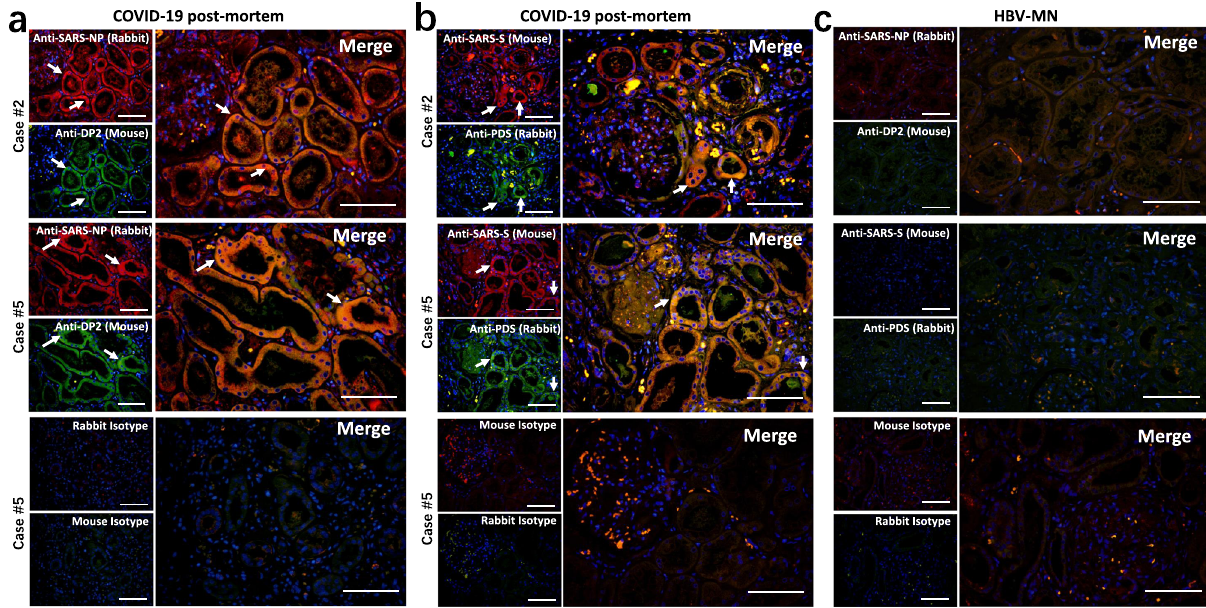
Fig. 4 SARS-CoV-2 protein antigens co-express with hypoxic damage-associated molecules in kidney. Immuno fl uorescent double staining was used to detect the expression of a SARS-CoV-2 NP (nucleocapsid protein) and DP2 in kidney tissues from COVID-19 post-mortem (case #2 and #5); b SARS- CoV-2 S (spike) and prostaglandin D synthase (PDS) in kidney tissues from COVID-19 post-mortem (case #2 and #5); c SARS-CoV-2 NP and DP2 or S and PDS in kidney tissues from hepatitis B virus-associated membranous nephropathy (HBV-MN). Here, sections only incubated with rabbit and mouse secondary antibodies were used as isotype controls. Arrow indicates positive cells. Scale bars = 100 μ m. Data represent one of at least three technical replication